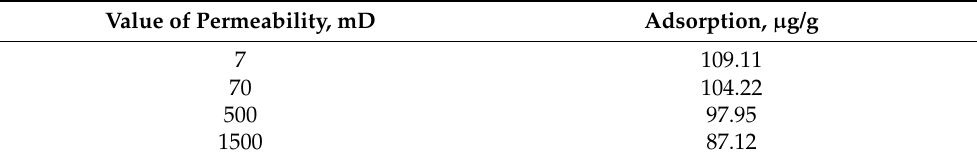
Table 7. Laboratory results of dynamic adsorption for different permeability models.